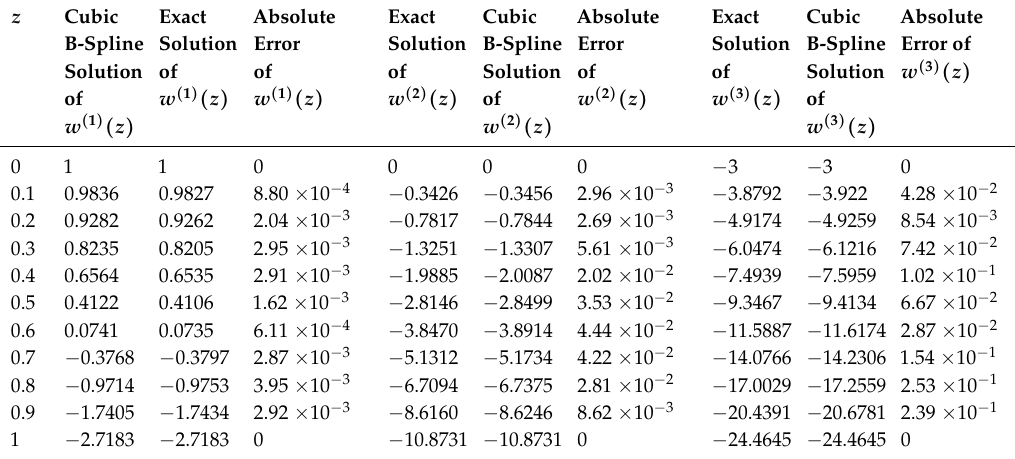
where boundary conditions are defined in Problem 10